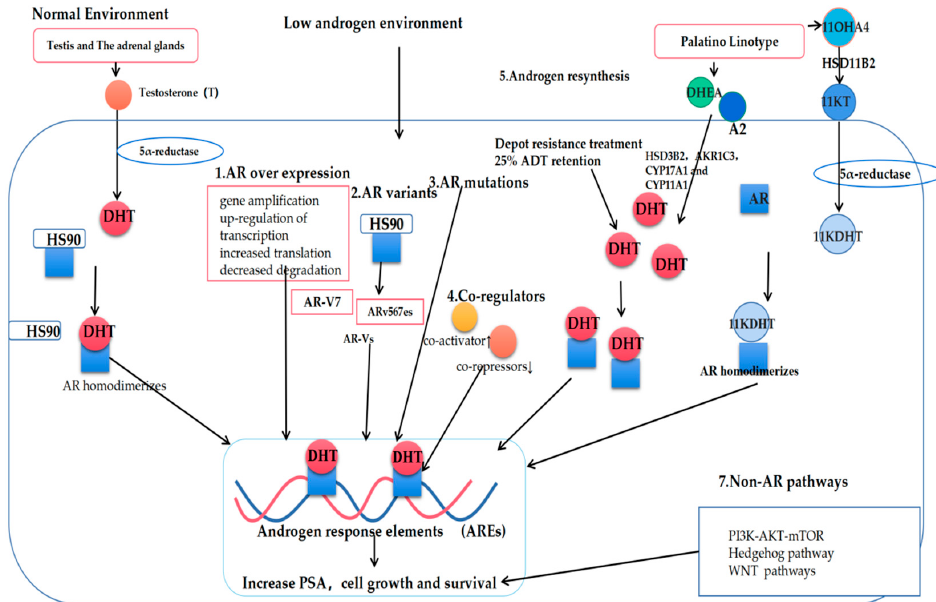
Figure 2. Mechanisms governing the progression of prostate cancer to castration-resistant prostate cancer (CRPC). T: Testosterone; DHT: Dihydrotestosterone; AR: Androgen receptor; AR-Vs: AR variants; DHEA: Dehydroepiandrosterone; A2: androstenedione; 11OXHA4: 11-oxygenated androgens; 11KT: 11-ketotestosterone; 11KDHT: 11-ketodihydrotestosterone.